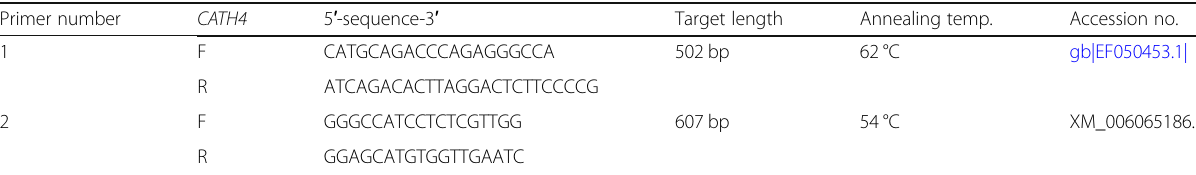
Table 1 Sequences of primer pairs used Primer number CATH4 5 ′ -sequence-3 ′ Target length Annealing temp.